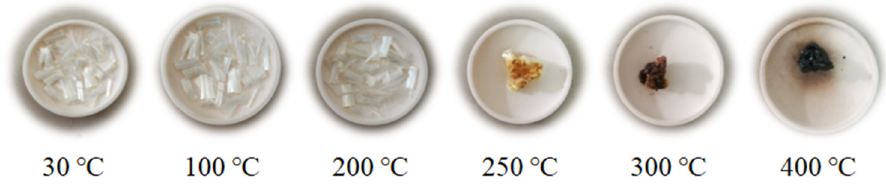
Figure 3. Morphologies of polyvinyl alcohol fiber under elevated temperatures.